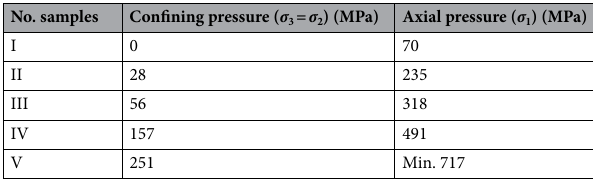
Table 2. The measured points of failure at the stress space for the sandstone (recalculated values) 24 .